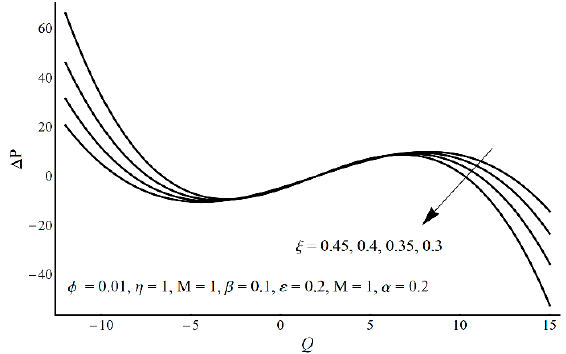
Figure 10. Pressure-rise per wavelength at various values of ε .